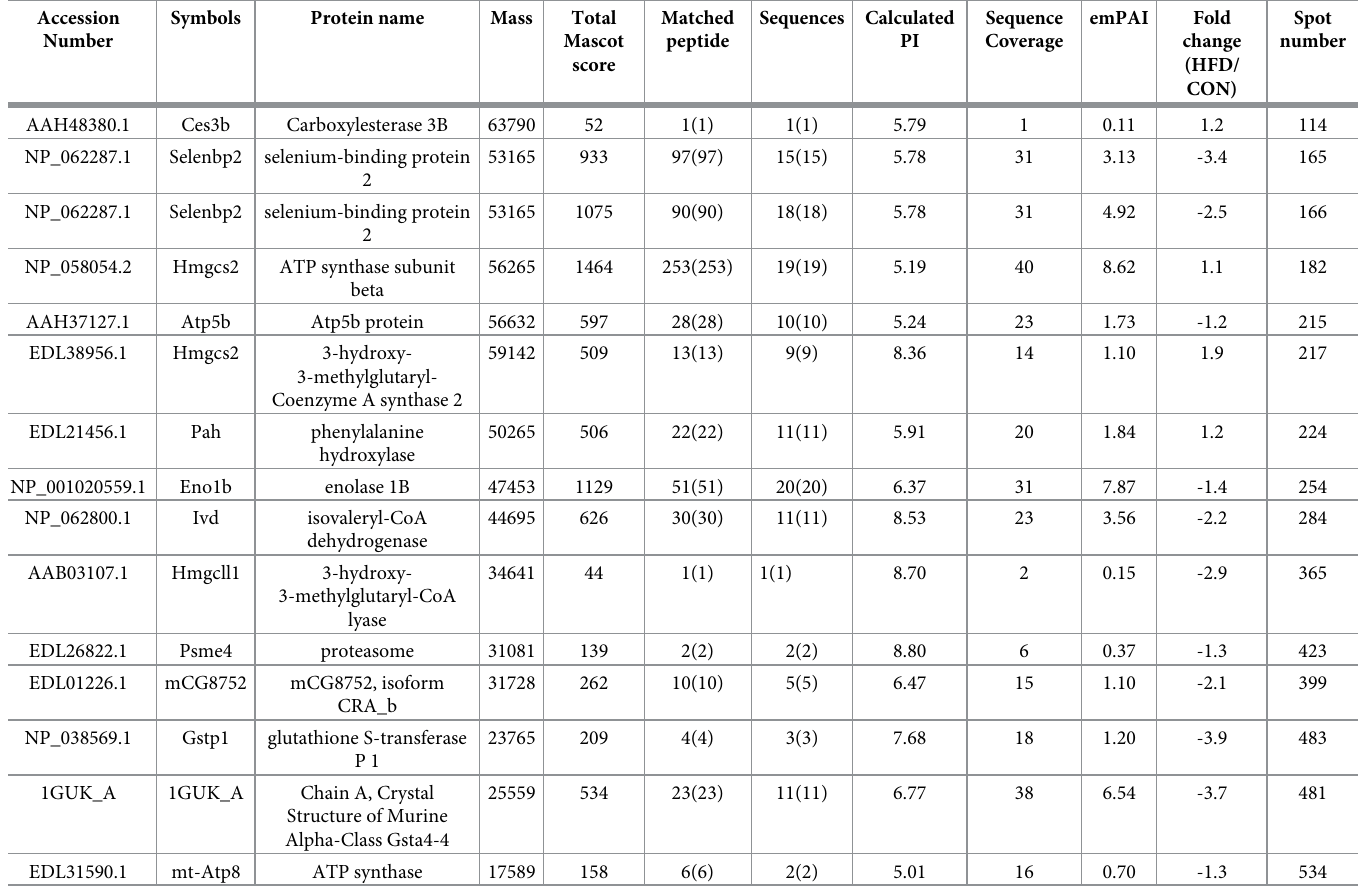
Table 1. Liver proteins differentially expressed in the HFD vs.